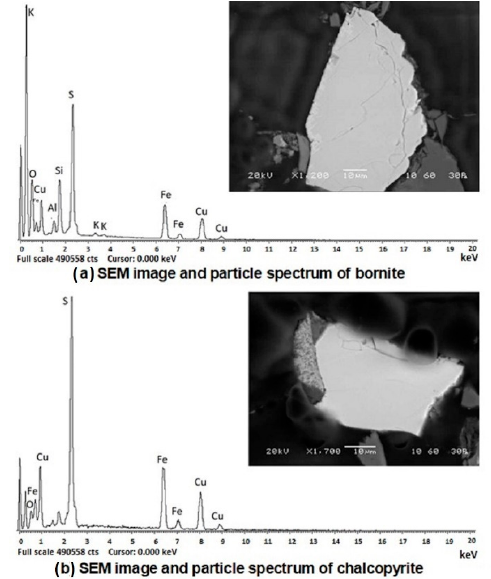
Figure 2. Micrograph and spectrum of mineralized particles of ( a ) bornite and ( b ) chalcopyrite.